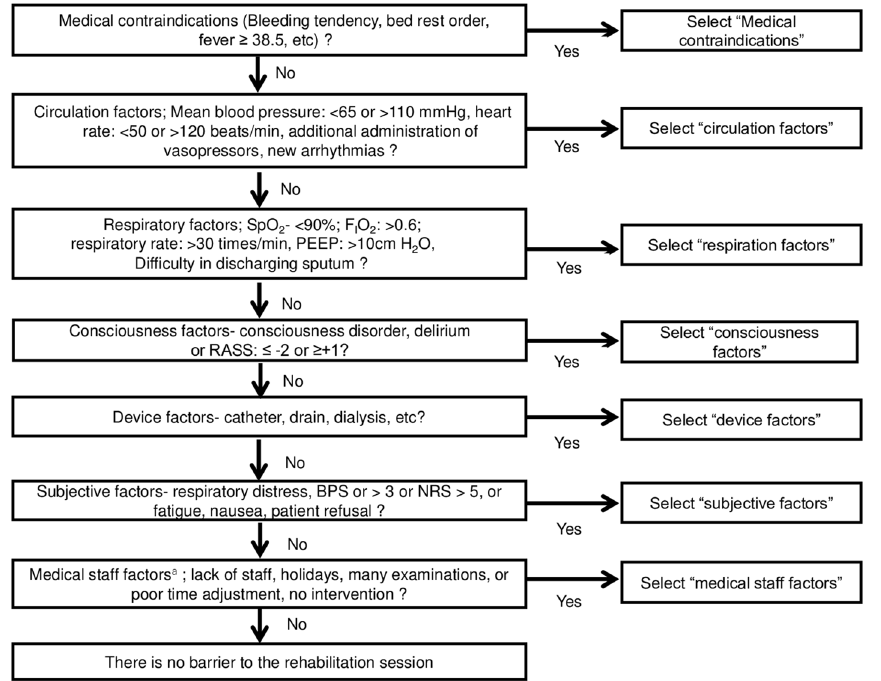
Figure 1. Flow chart of the patient selection process. ICU intensive care unit. Superscript a: neurological complications include cerebral infarction, cerebral hemorrhage, acute subdural hematoma, acute epidural hematoma, traumatic subarachnoid hemorrhage, and encephalitis. Superscript b: mental and cognitive diseases include depression, anxiety, schizophrenia, dementia, cerebral infarction, cerebral hemorrhage, dementia,